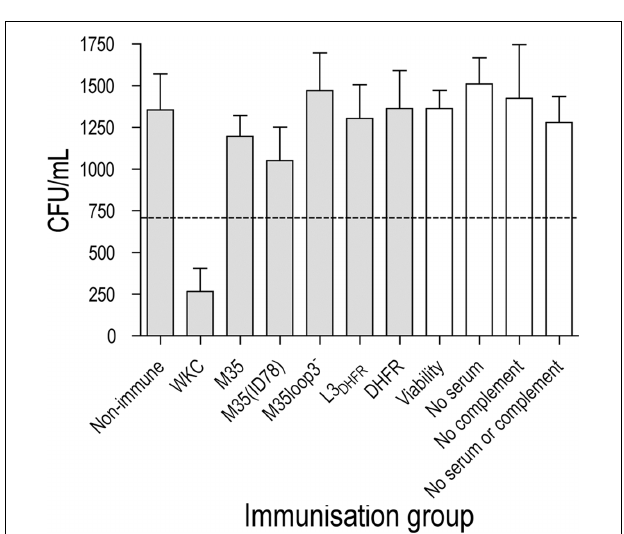
BACTERIAL RECOVERY FROM MOUSE LUNGS AFTER CHALLENGE WITH LIVE M.